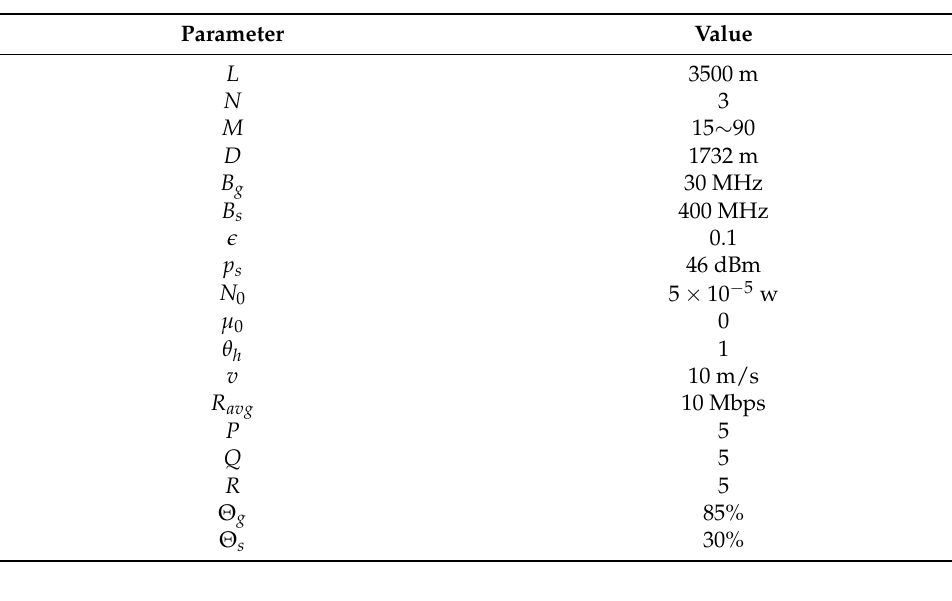
Table 1. Parameter configuration.